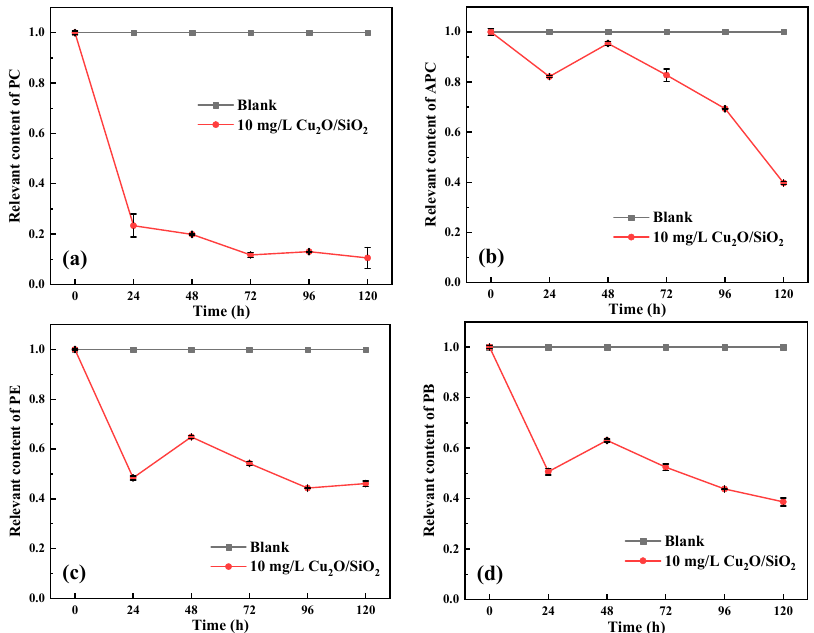
Figure 10. Changes of ( a ) phycocyanin, ( b ) allophycocyanin, ( c ) phycoerythrin, and ( d ) phycobiliprotein content of algae during the experiment.